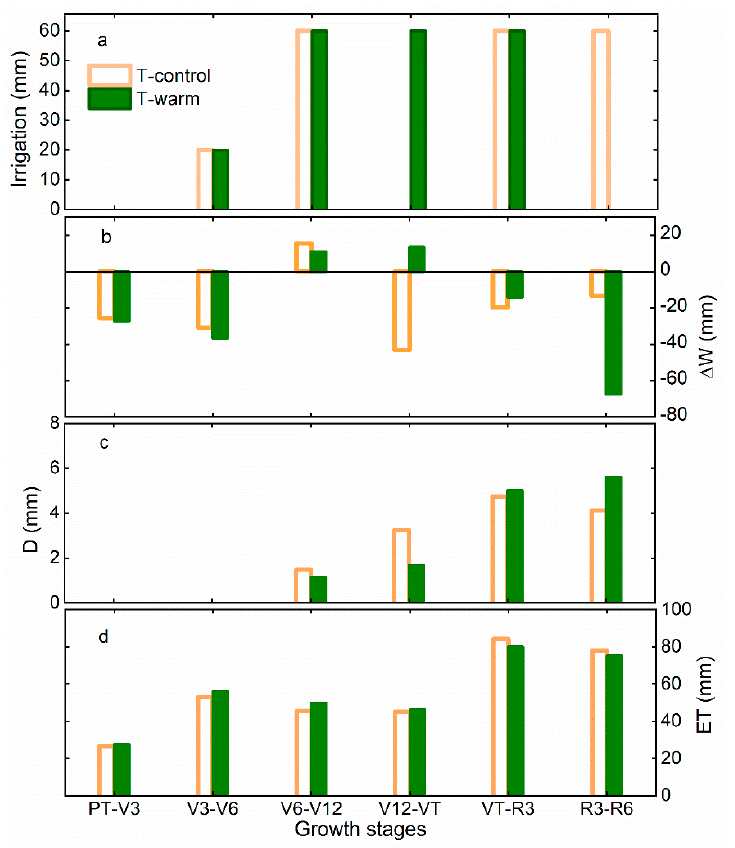
Figure 6. Seasonal variations in ( a ) irrigation, ( b ) Δ W, ( c ) D and ( d ) ET at different growth stages of maize under T-control and T-warm